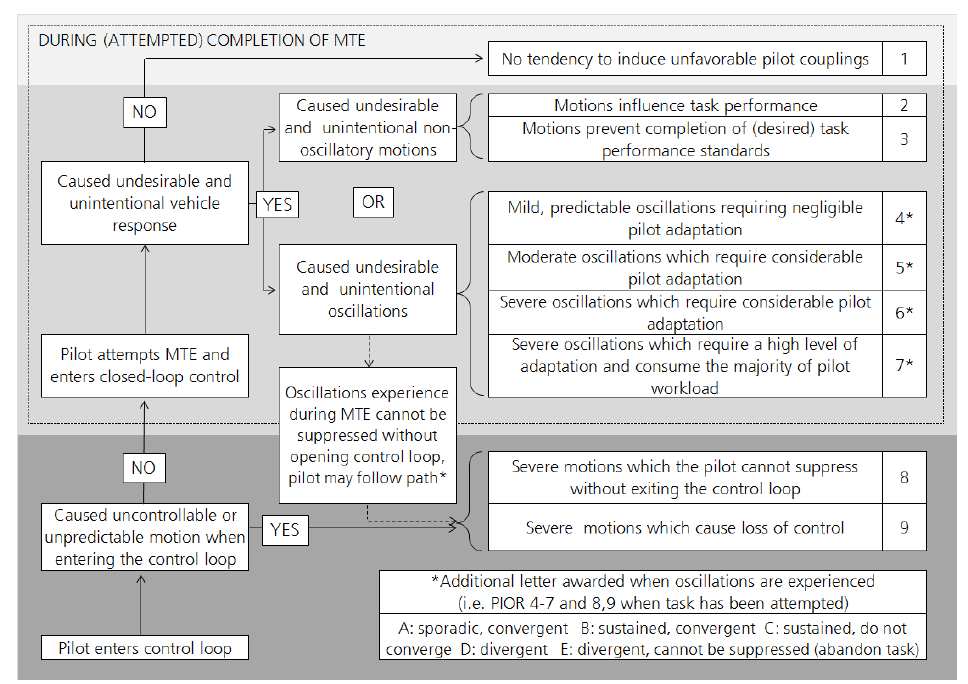
Figure 8. Adverse pilot coupling (APC)